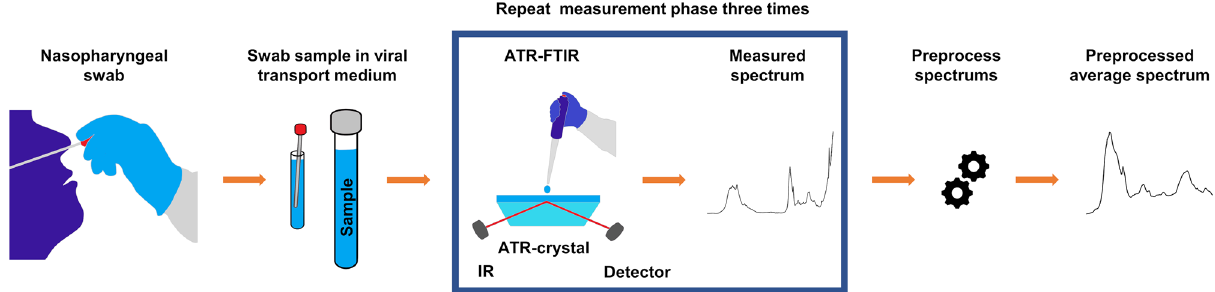
Figure 1. Data acquisition. A routine nasopharyngeal swab sample was dissolved into the viral transport medium, analyzed with PCR, and the remnant from that sample was stored in the freezer. The frozen swab sample was thawed and inactivated by adding a viral lysis buffer liquid before the ATR-FTIR measurements. The measurement was conducted by pipetting a one drop from sample solution containing the nasopharyngeal swab sample, the viral lysis buffer and the viral transport medium onto the ATR crystal. Pipetting and measurement was repeated three times to obtain three spectra from each sample. Those three measured spectra were finally averaged so that there was one representative spectrum from each nasopharyngeal swab sample. Before ATR- FTIR measurement, the sample was vortexed to have as homogeneous material distribution as possible, and spun with centrifuge to set the whole sample to the bottom of the